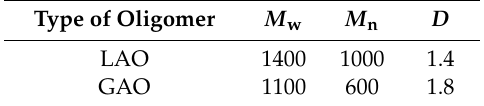
Table 2. Molecular weight and molecular weight distribution of GAO and